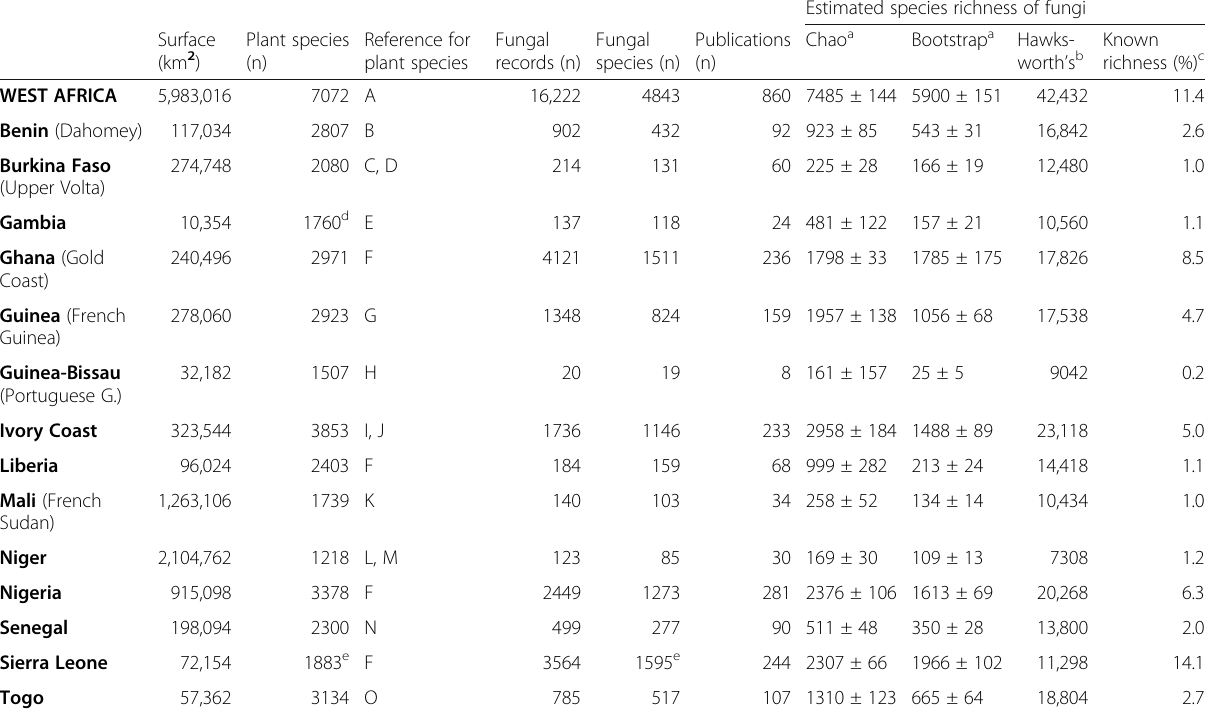
Table 1 Current (and historical) names and surface areas of West African countries, known species diversity of plants according to literature, and known and estimated species diversity of fungi according to data in the checklist for fungi in West